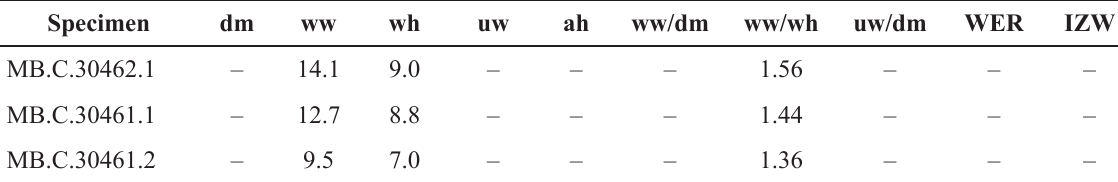
Table 8. Conch dimensions (in mm) and ratios of Vestinautilus angulatus sp. nov.